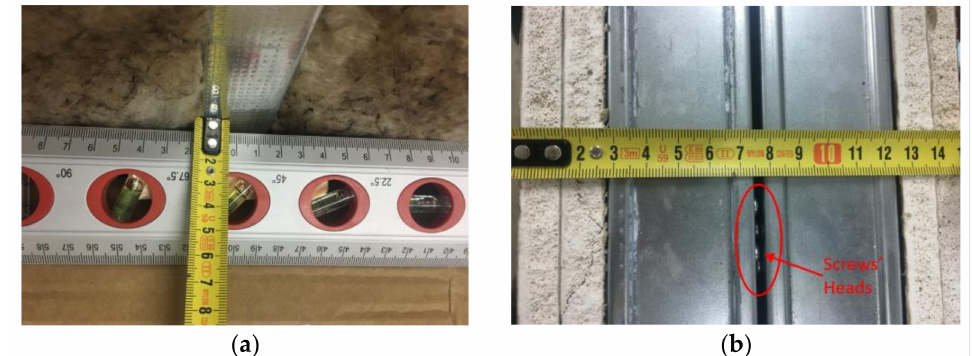
Figure 4. Geometry details of the measured double pane LSF wall test sample. ( a ) Expansible MW around steel stud; ( b ) Steel track